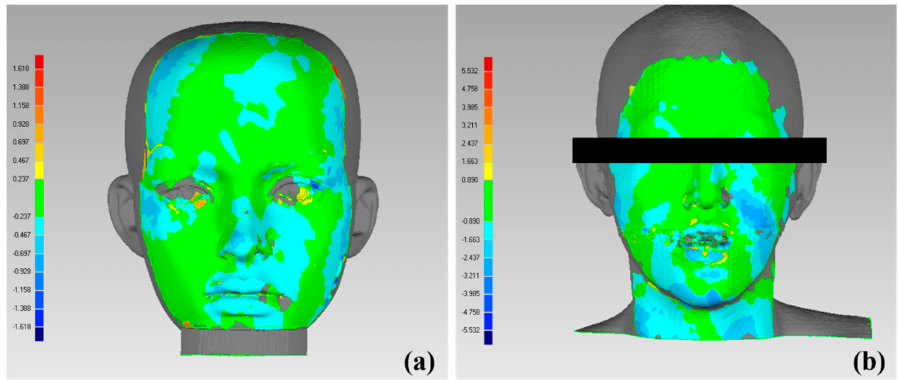
Figure 5. Three-dimensional registration error based on the modified CPD in the mannequin phantom ( a ) and in the patient ( b ).